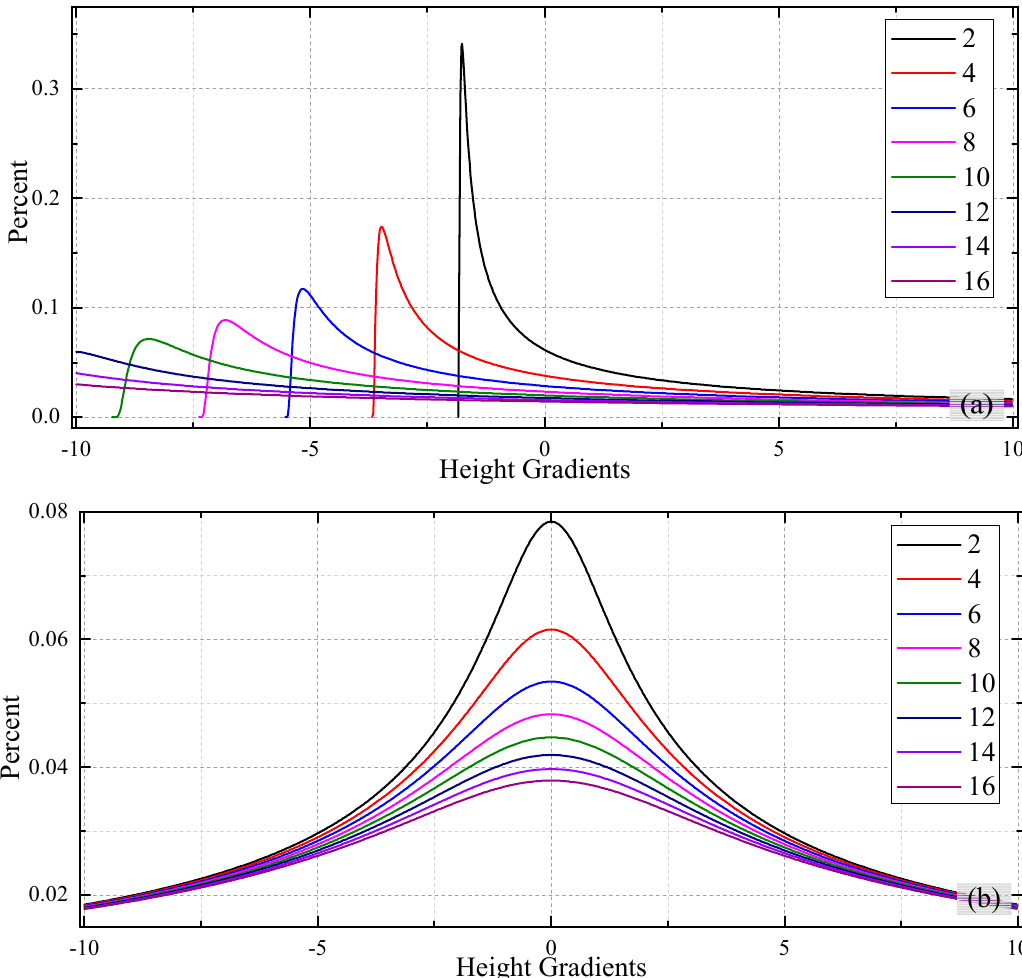
Figure 1. Relationship between pixel spacing and the probability density distribution function of elevation gradients in ( a ) the range direction and ( b ) the azimuth direction. Lines are the pixel spacing with different multi-look numbers.